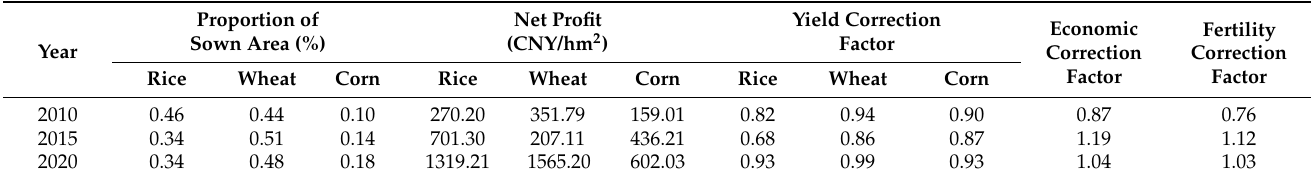
Table 2. Coefficient correction data table.